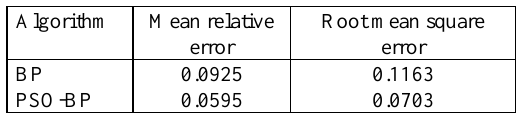
Table 4 . Evaluation of algorithm prediction results From Table 4, the mean relative error and root mean square error of PSO-BP algorithm are smaller than those of BP algorithm, which indicates that the PSO-BP algorithm has better prediction results. Tables 5 show the number of test sets in different error rate ranges for each of the two algorithms. The proposed PSO-BP algorithm achieves better comparing with traditional BP algorithm.